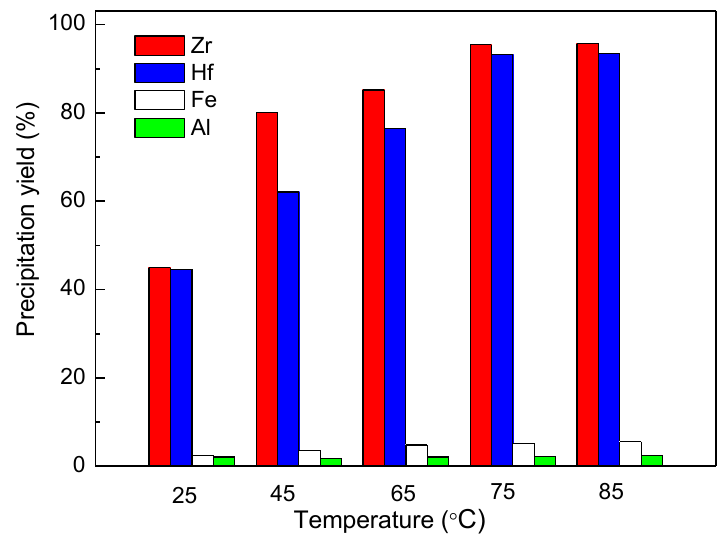
Figure 8. E ff ect of temperature on the Zr precipitation yield, Zr precipitation conditions: final pH ~1.6, C(SO 4 2 − ) = 12.4 g / L, 60 min.